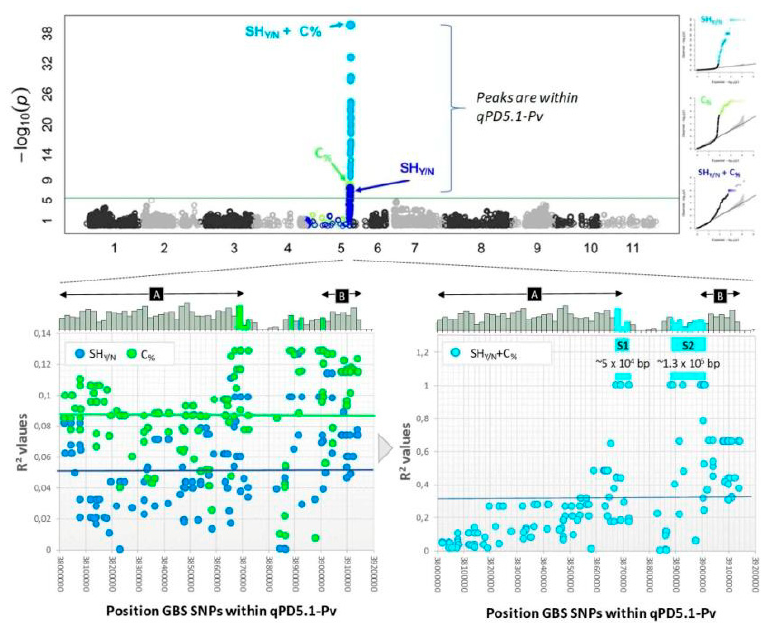
Figure 9. Manhattan plot from the genome-wide association study data when the trait SHyn+C% was mapped. The strongest QTL was identified for chromosome Pv05 ( top ). The single traits Shy/N and C% mapped in the same genomic regions ( bottom left ). Two sub-regions (S1, S2) co-segregated with the combined trait (SHyn+C%) with R2 = 1.00 ( bottom right ) (reproduced with permission from Rau et al. [22]).